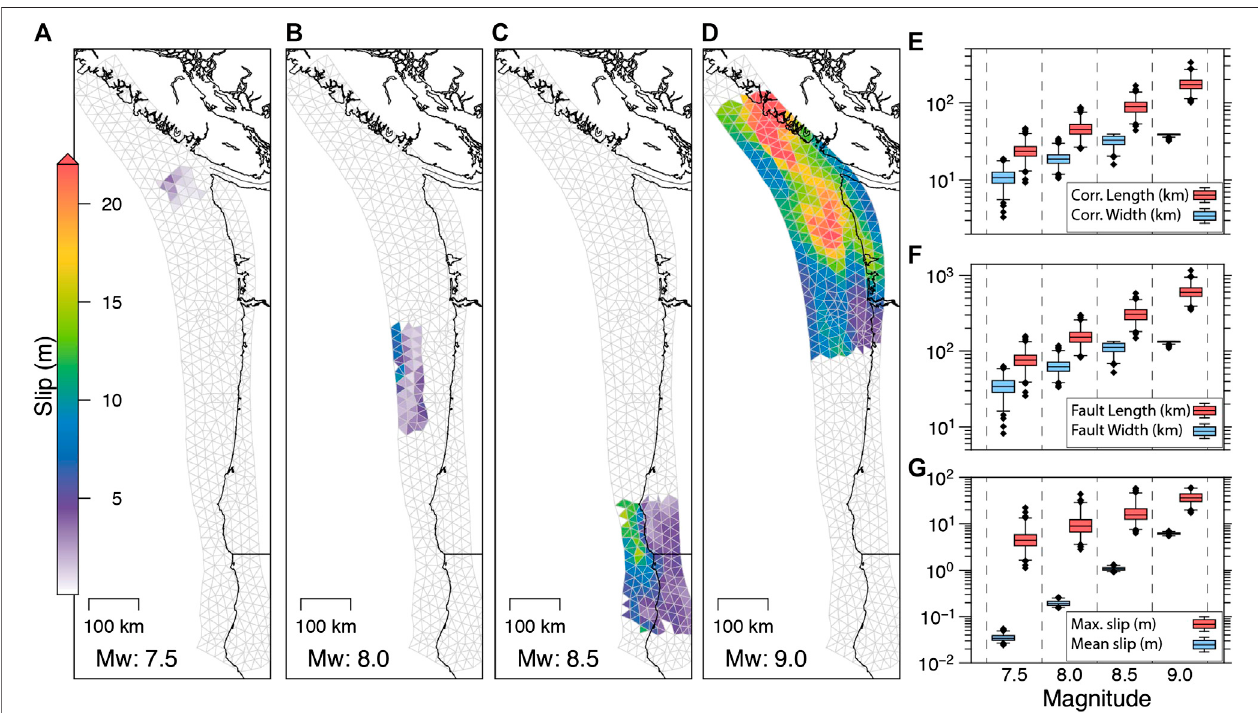
FIGURE1|(A – D) Exampleearthquakerealizationsforeachmagnitudeclass. (E) Variabilityincorrelationlengthandwidthpereachmagnitude. (F) Variabilityintotal fault length and width per magnitude class. (G) Variability in mean and maximum slip, in meters, for realizations in each magnitude class.